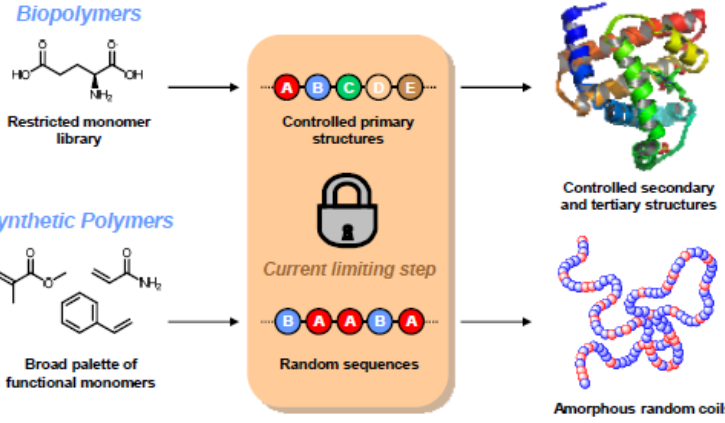
Figure 2. A schematic representation of controlled comonomer sequences: a key-step toward highly organized polymer-based materials [88].